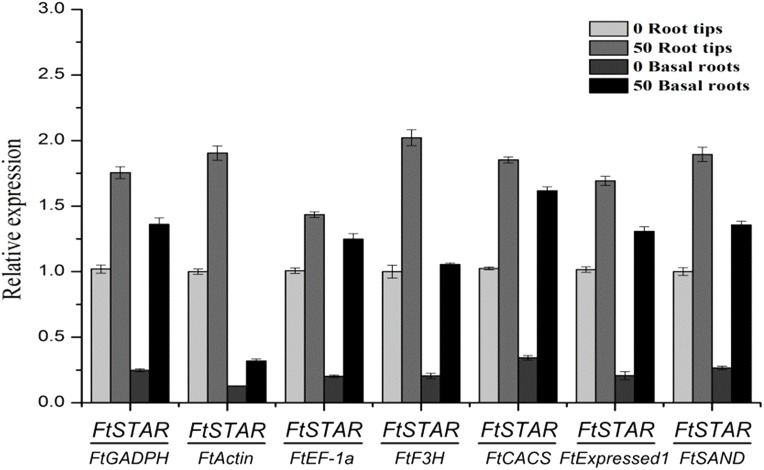
Relative quantification of FtSTAR2 gene expression under Al treatment in tartary buckwheat.Error bars represent standard deviation of the mean, data shown are means ± SD (n = 3).